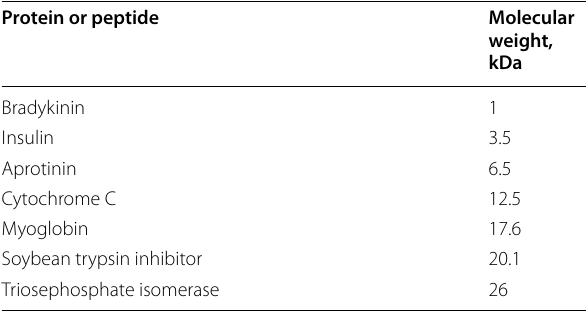
Table 1 Molecular weights of standard proteins and peptides Protein or peptide Molecular